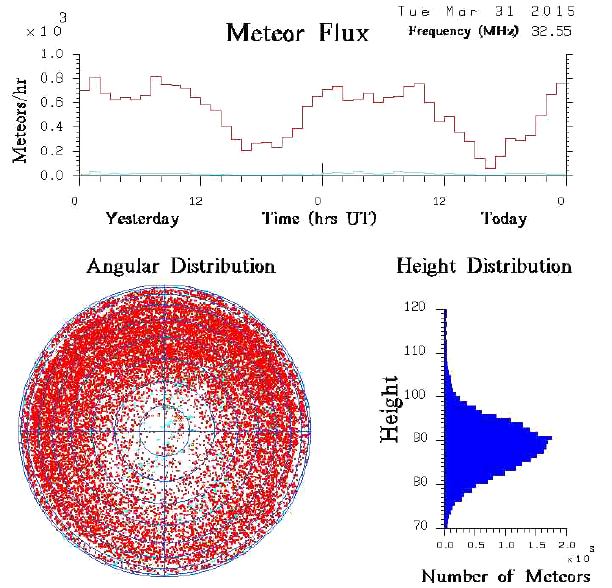
Figure 45. Number, direction and altitude of the meteor echoes, recorded in Juliusruh for the last 48h on 31 March